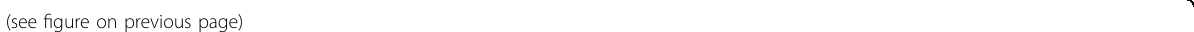
Fig. 2 MCL-1 as a novel vulnerability for combination therapy in mantle cell lymphoma (MCL) and diffuse large B cell lymphoma (DLBCL). A Heatmap of AUCs of drug – response curves from image-based cell-viability assays performed in MR cells with and without the presence of S63845 as an anchor drug for indicated cell lines. B Left: Image-based cell-viability assays of primary MCL and DLBCL samples co-cultured with stroma cells in response to treatment with S63845, SCH772984, or S63845 + SCH772984. Right: Image-based cell-viability assays of primary patient samples co- cultured with stroma cells in response to treatment with S63845, Trametinib, or S63845 + Trametinib. C Quartile box plots of drug sensitivity as determined by AUCs of image-based cell-viability assays in primary MCL samples. P values between treatment groups were calculated with the Friedman Conover Test. Top: Primary samples treated with S63845, SCH772984, or S63845 + SCH772984. n = 7. Bottom: Primary samples treated with S63845, Trametinib, or S63845 + Trametinib. n = 13. D Western blot analysis of BCL-2 family proteins in MR cells after 48 h treatment with S63845 (2 μ M), Trametinib (2 μ M), or SCH772984 (2 μ M). E Heatmap of top differentially expressed genes between primary S63845-resistant and S63845- sensitive patient samples de fi ned by AUCs calculated from image-based cell-viability assays. F Scatterplot of GSEA-positive NES of the Hallmarks gene set from MsigDB in primary patient samples phenotypically characterized by S63845 sensitivity as determined by AUCs calculated from image-based cell-viability assays. FDRq cut-off of 0.25. Data shown in A and D are representative of at least three independent